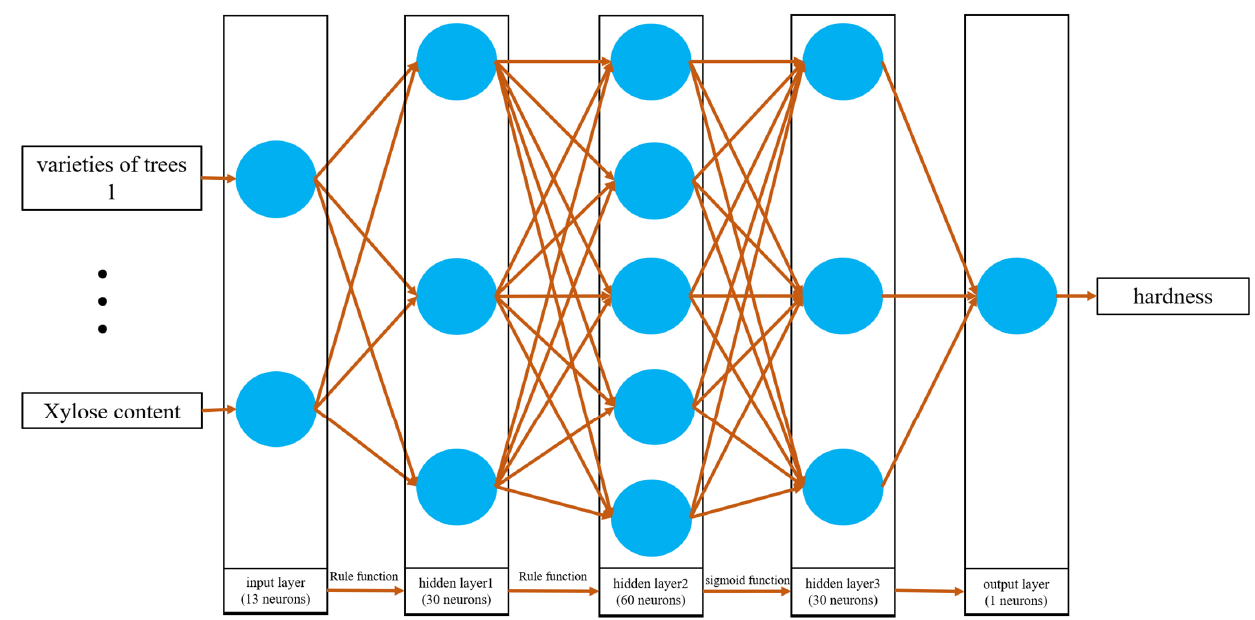
Figure 1. The artificial neural network Figure 1. The arti fi cial neural network structure. The mean absolute percentage error (MAPE), root mean square error (RMSE), and determination coe ffi cient (R 2 ) was utilized to evaluate the performance of the ANN. The MAPE and RMSE values were considered the most important performance criteria, while